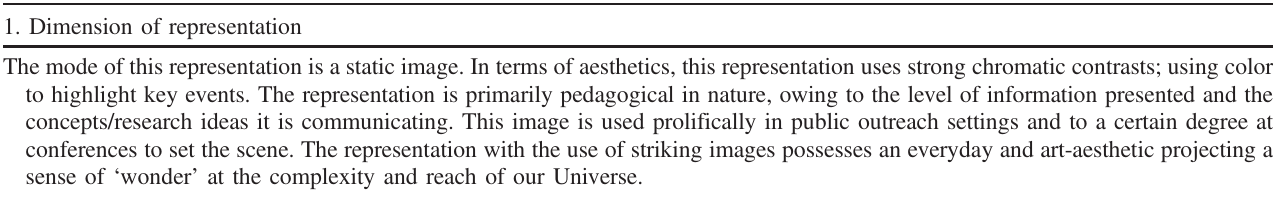
TABLE III. Unpacking the representation of the evolutionary timeline of the Universe (Fig. 14).